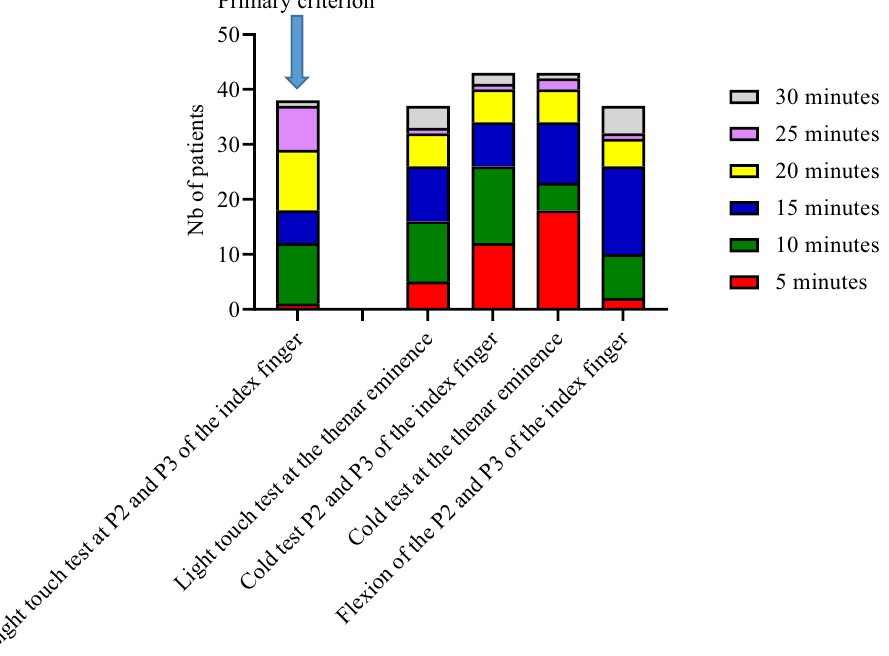
Figure 2. Repartition of onset time for successful block according to the sensory and motor test results.